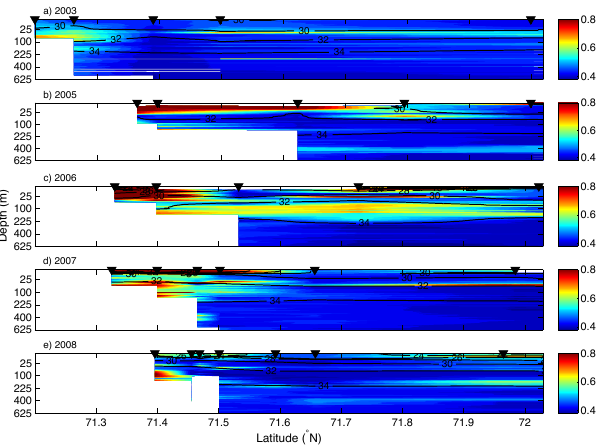
Fig. 9. As in Fig. 8 but for the western Beaufort shelf region for the years (a) 2003, (b) 2005, (c) 2006, (d) 2007, and (e) 2008. This section was not sampled in 2004. Note that the attenuation range is about double what it was in Fig. 8.